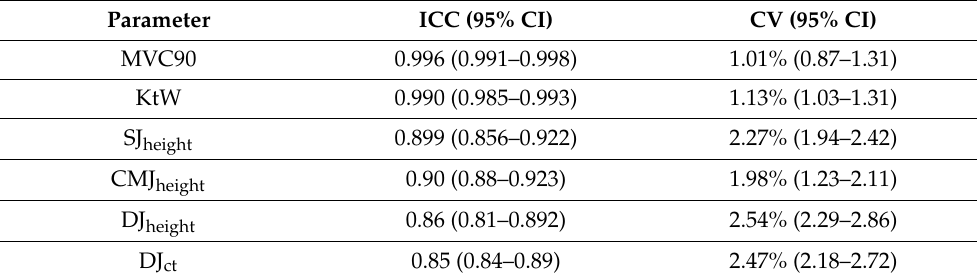
Table 2. Intraclass correlation coefficients with 95% confidence interval, and 95% confidence interval of the included